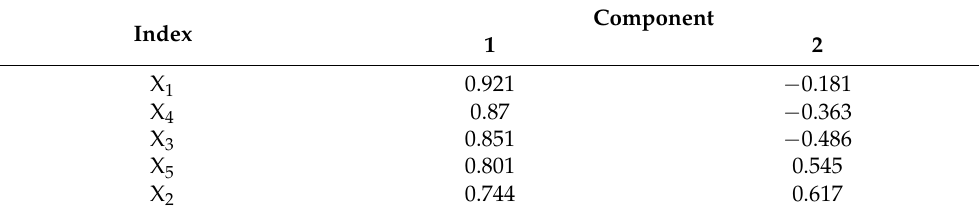
Table 7. Principal component load